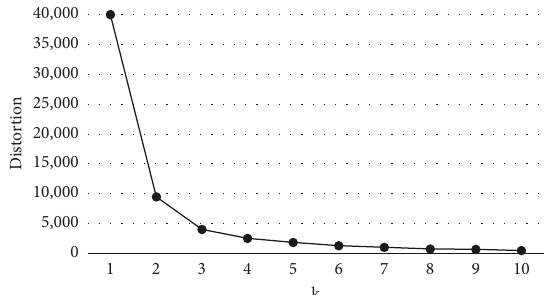
Figure 8: Distortion based on different ( k ) values for the 2019 dataset.